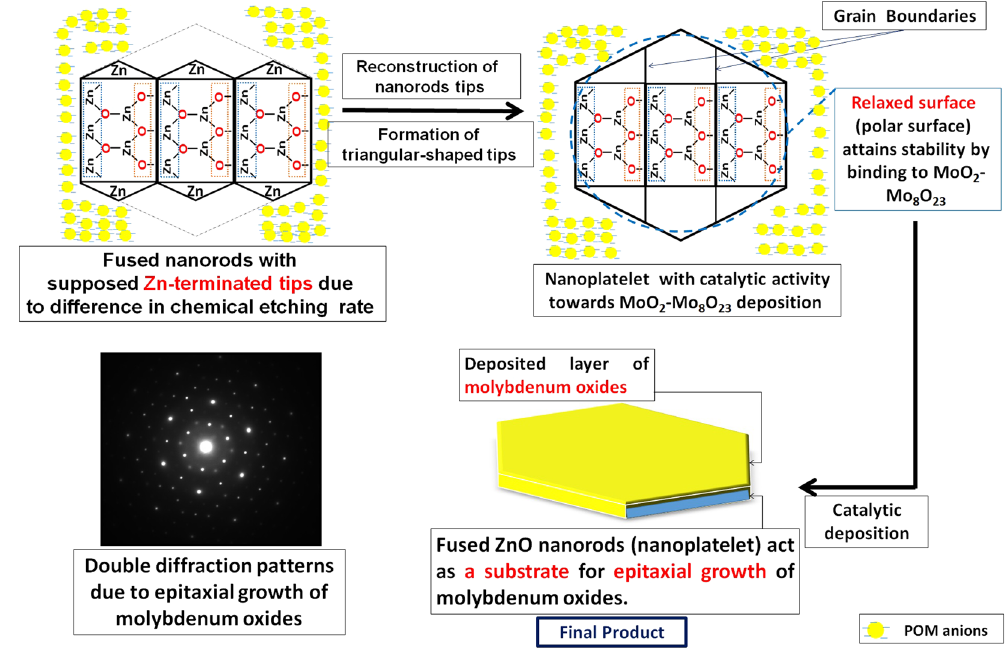
Figure 17. Schematic illustration for reconstruction of nanorods tips to triangular structure and the epitaxial growth of molybdenum oxides over ZnO